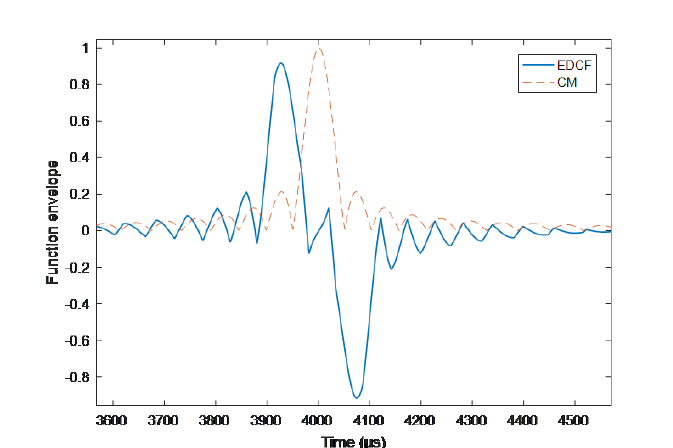
Figure 3. Differential correlation results when τ z = 70 µ s.